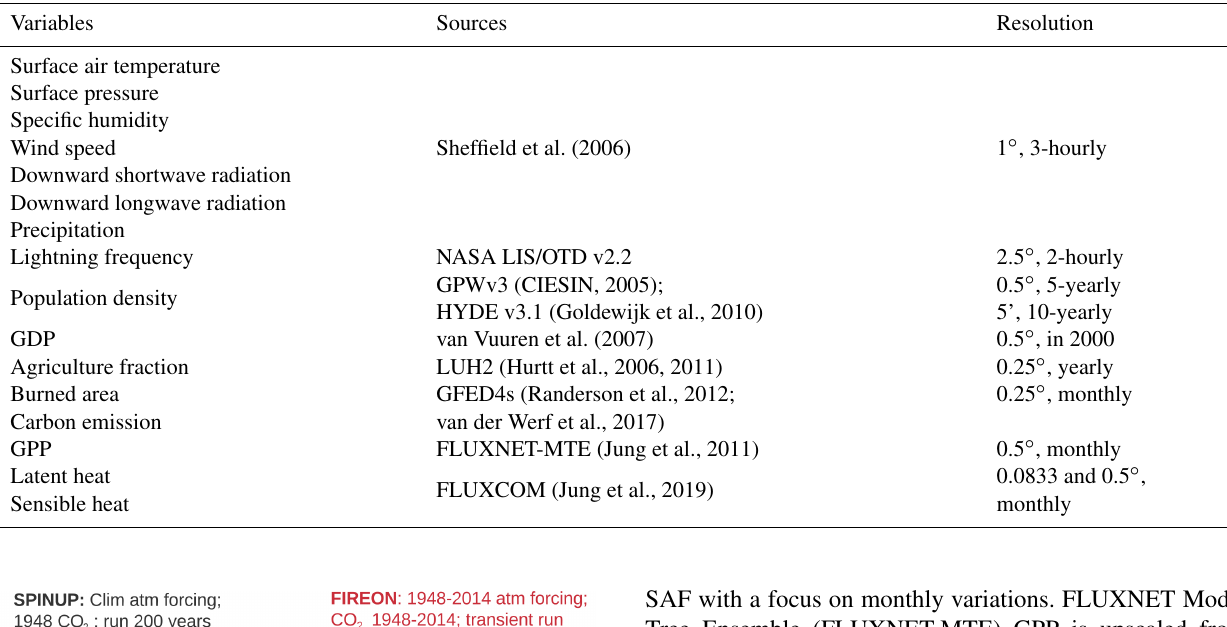
Table 1. Datasets used to drive SSiB4/TRIFFID-Fire and evaluate simulations.